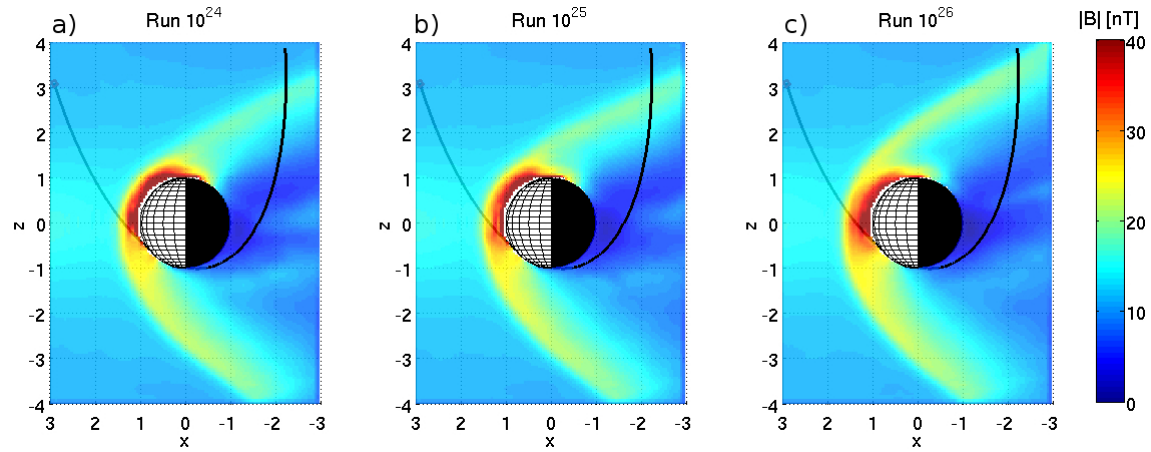
emission rates. The th